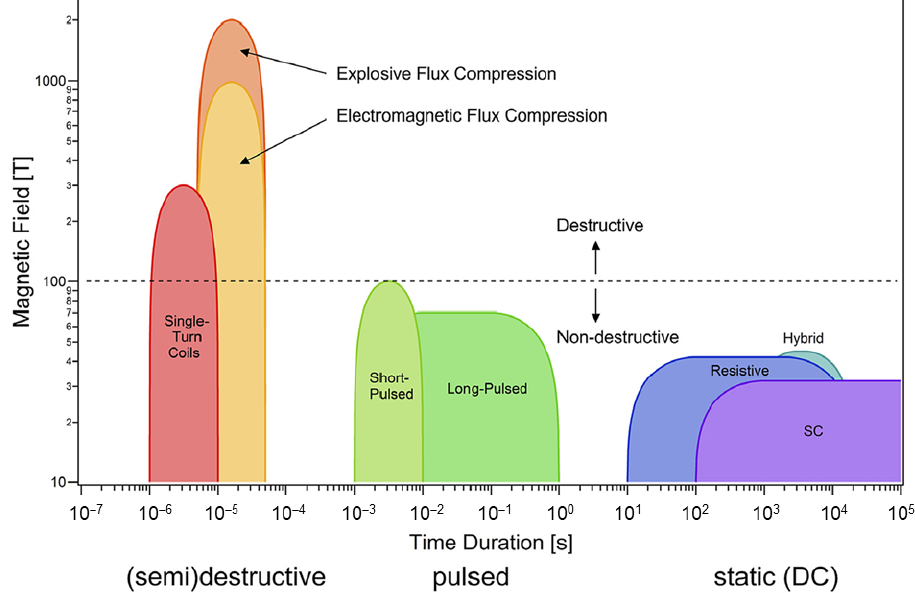
Figure 1. Overview of high magnetic field generation methods depending on amplitude and duration. (SC stands for Superconducting). Reprinted with permission from [13]. © 2018 Elsevier